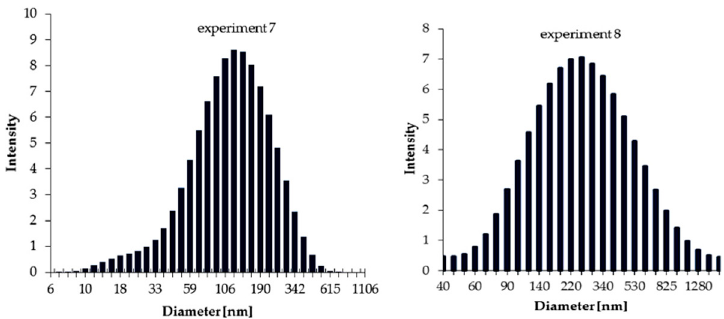
Figure 8. Particle size distribution histograms of AgNPs obtained by DLS measurements.